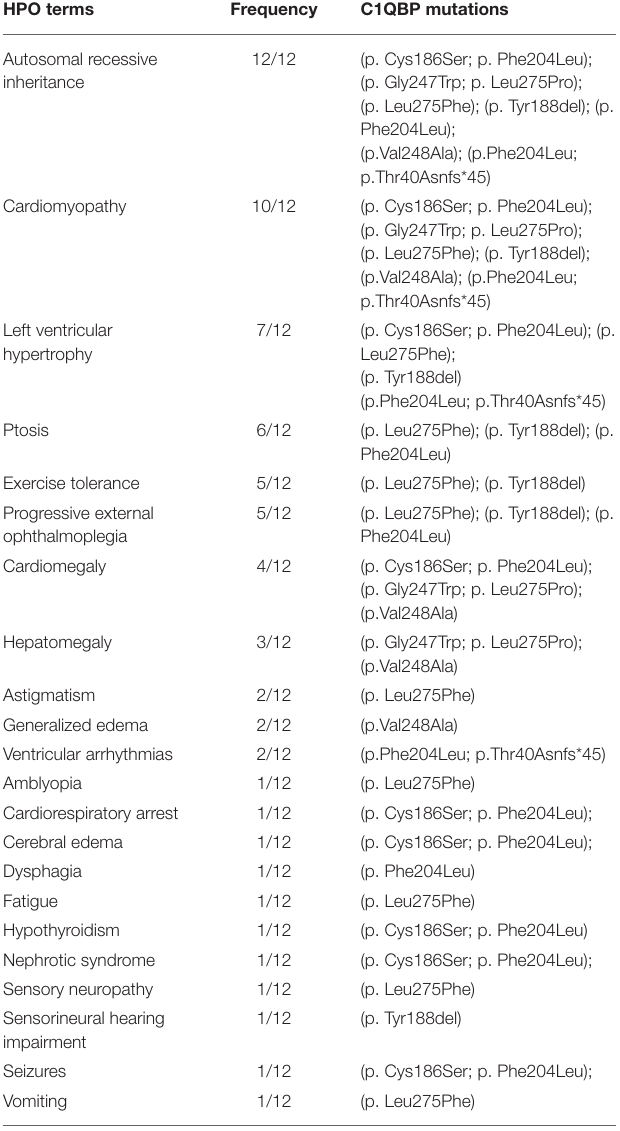
TABLE 2 | The relative frequency of symptoms associated with biallelic variants in C1QBP and the related HPO